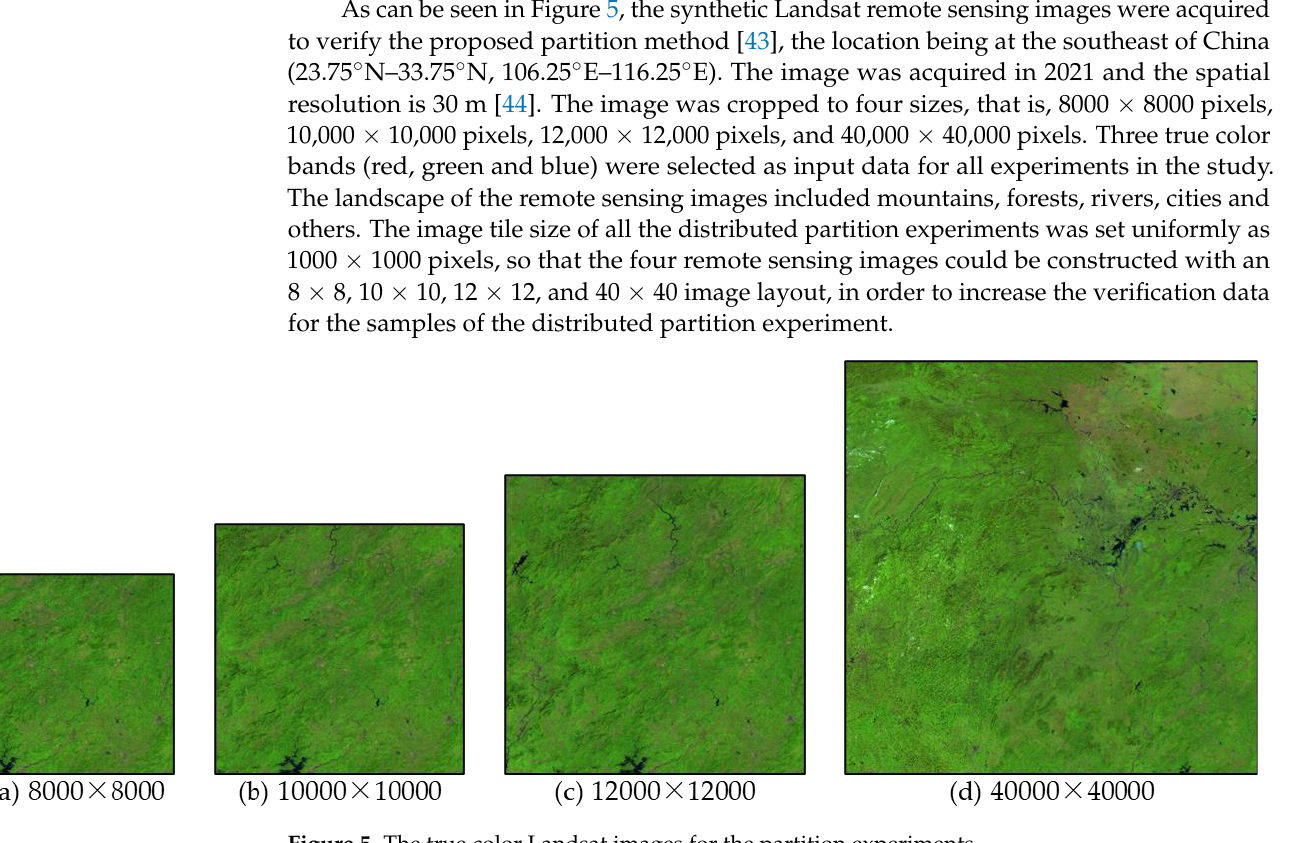
Figure 5. The true color Landsat images for the partition experiments.